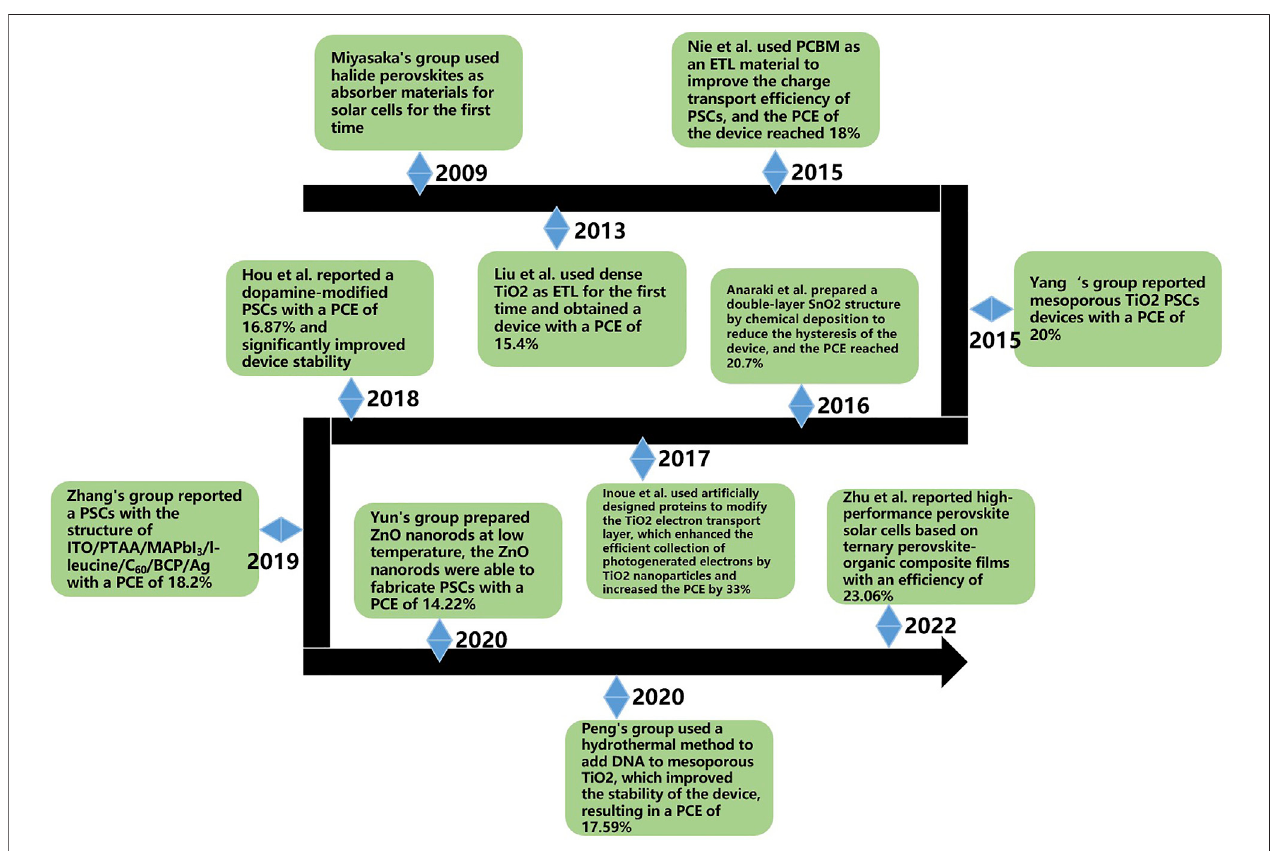
FIGURE 4 | Timeline for the development of ETL materials for perovskite solar cells.